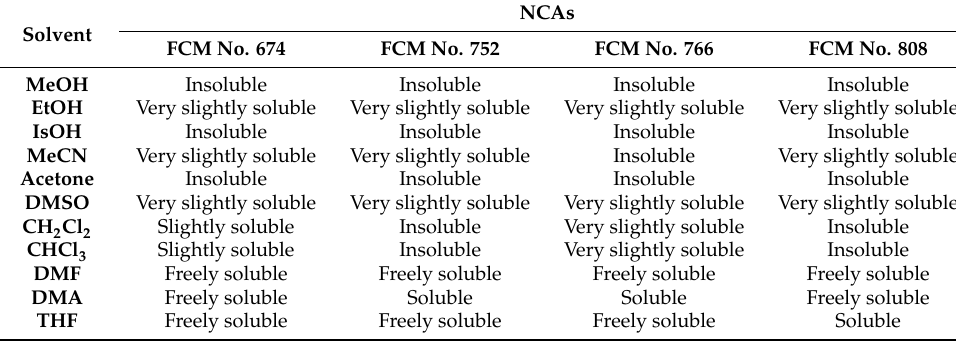
Table 2. Results of solubility studies for the studied NCAs.